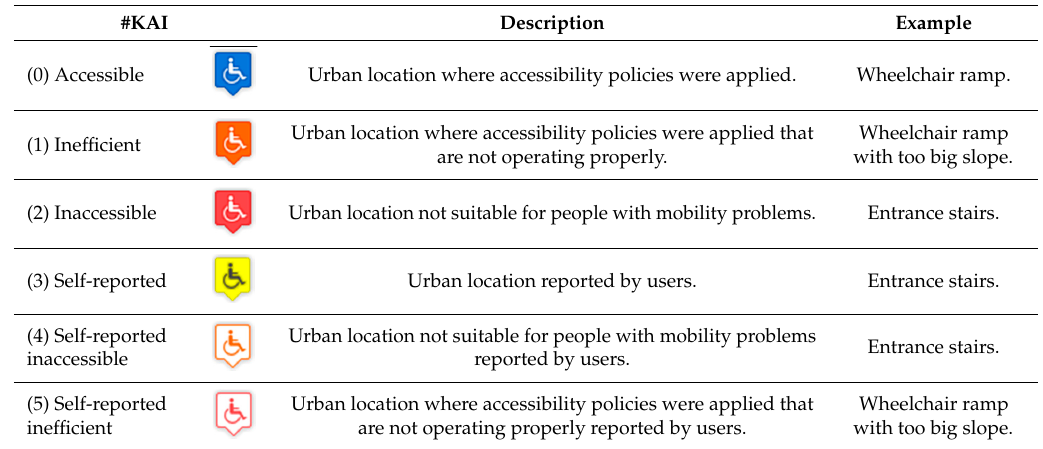
Table 2. Type of urban locations according to accessibility treatment.